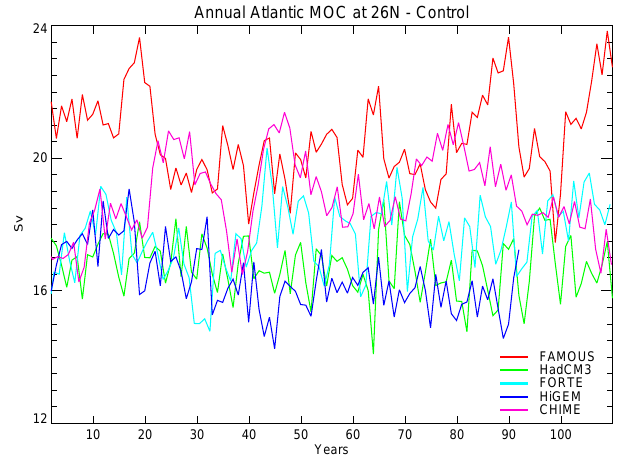
Fig. 7. Annual time series of the Atlantic MOC ( T over ) at 26 ◦ N (HiGEM data is only 90yr long after the spin-up Figure 7: Annual time series of the Atlantic MOC ( T over ) at 26 o N (HiGEM data is only 90 years long after the spin-up time).